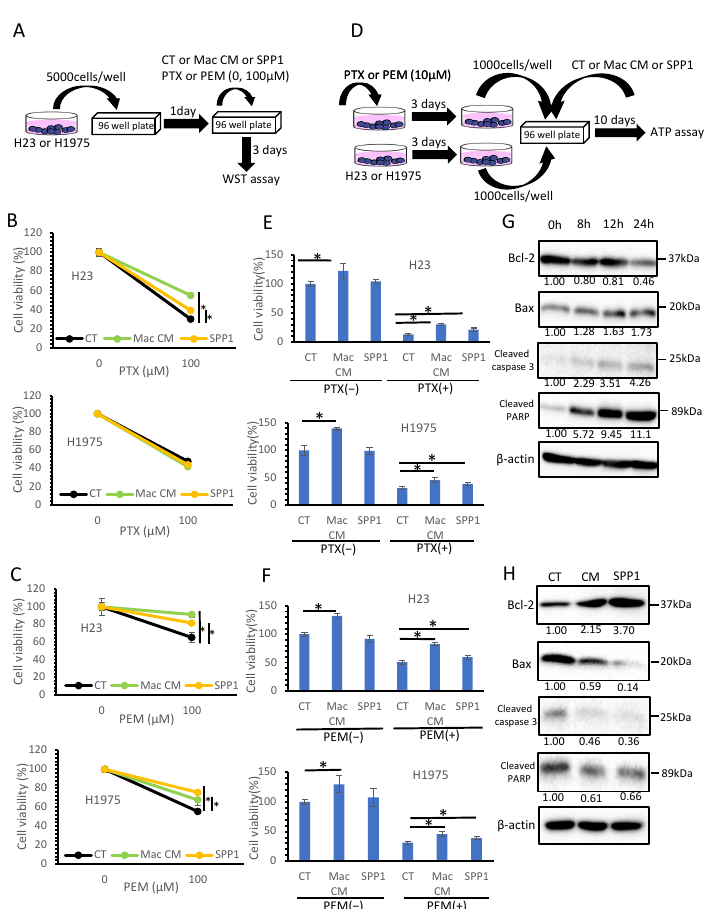
PEM(+) Figure 6. SPP1 and chemo-resistance in lung cancer cell lines. ( A ) Schema showing the 2D cell culture method for testing the chemo-sensitivity of the H23 and H1975 cell lines. Cells were cultured with or without the CM of macrophages and SPP1 and treated with PTX ( B ) or PEM ( C ). Cell viability was tested by the WST assay. ( D ) Schema showing the 3D cell culture method for testing the re-growth of the H23 and H1975 cell lines. Cells were cultured with or without the CM of macrophages and SPP1 and treated with PTX ( E ) or PEM ( F ). Cell viability was tested by an ATP assay. ( G ). Apoptosis- related molecules when PTX was added to H23 cells. ( H ) H23 cells were cultured with the CM of macrophages or SPP1 and treated with PTX for 1 day; then, the expression levels of apoptosis-related molecules were examined by Western blot analysis. CT refers to cancer cell lines without the CM of macrophages and SPP1 added. *: statistically significant, p value <